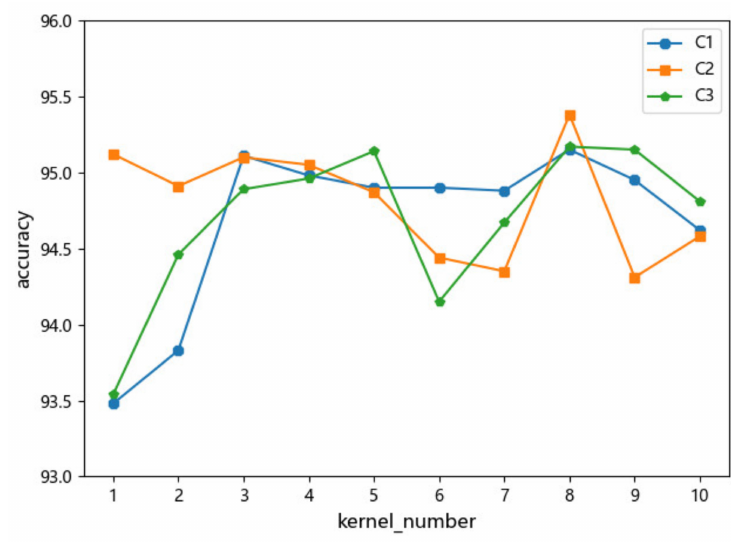
Figure 7. HDLN’s Accuracy under different kernel